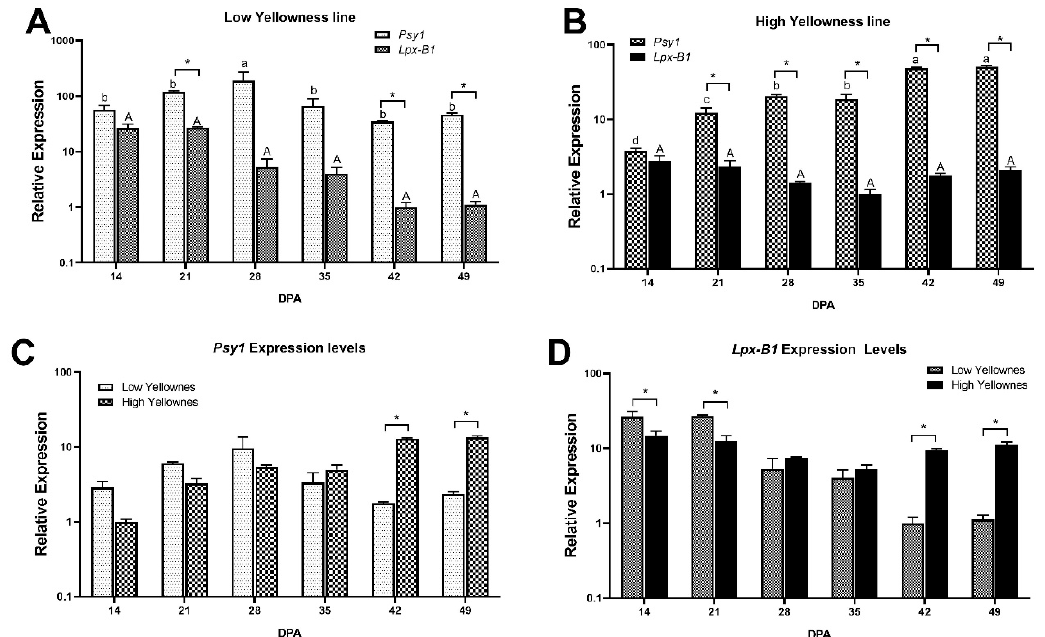
Figure 3. Relative expression of Psy1 and Lpx-B1 genes during the grain filling stage in high and low yellowness Mediterranean genotypes. ( A ), relative expression in a low yellowness genotype during grain filling. ( B ), relative expression in a high yellowness genotype during grain filling. ( C ), comparison of the relative expression of Psy1 between high and low yellowness genotypes during grain filling. ( D ), comparison of the relative expression of Lpx-B1 in high and low yellowness genotypes. Two-way ANOVA and Tukey’s post hoc test were performed ( p < 0.05). Upper and lower case are used to compare DPAs for each gene or genotype, an asterisk is used to denote statistical significance between conditions at each DPA. DPA, days post anthesis. All bars represent the mean of three biological and technical replicates ( n = 9).